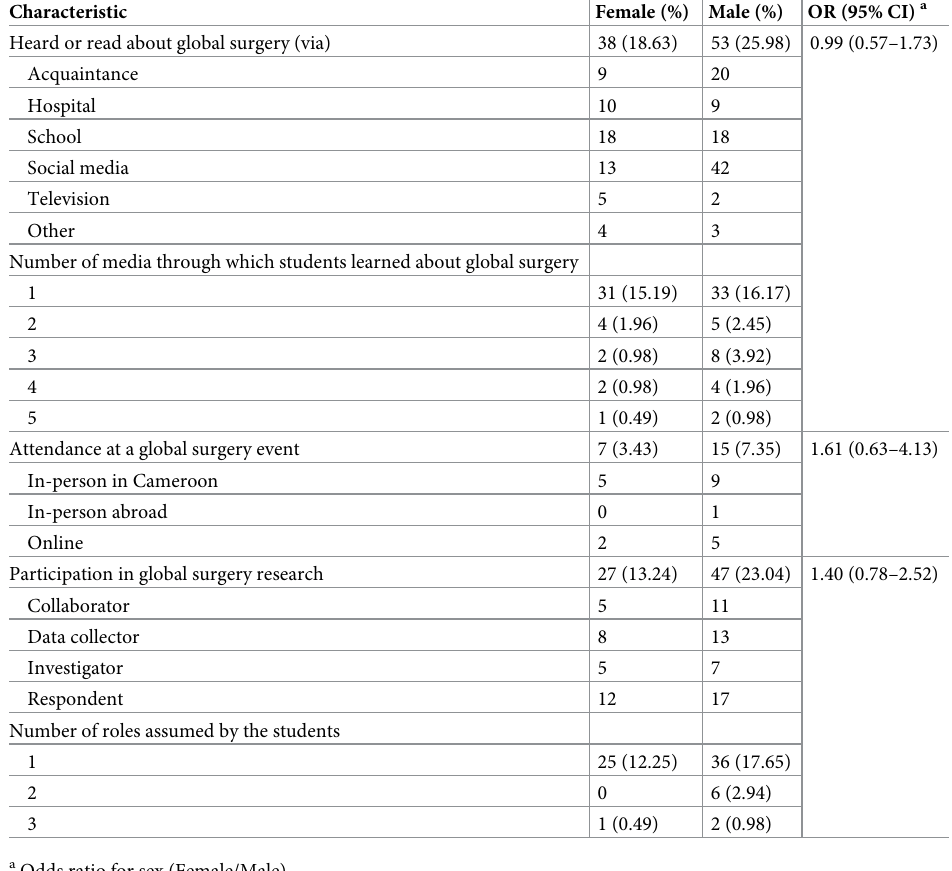
Table 1. Global surgery experiences of cameroonian final year medical